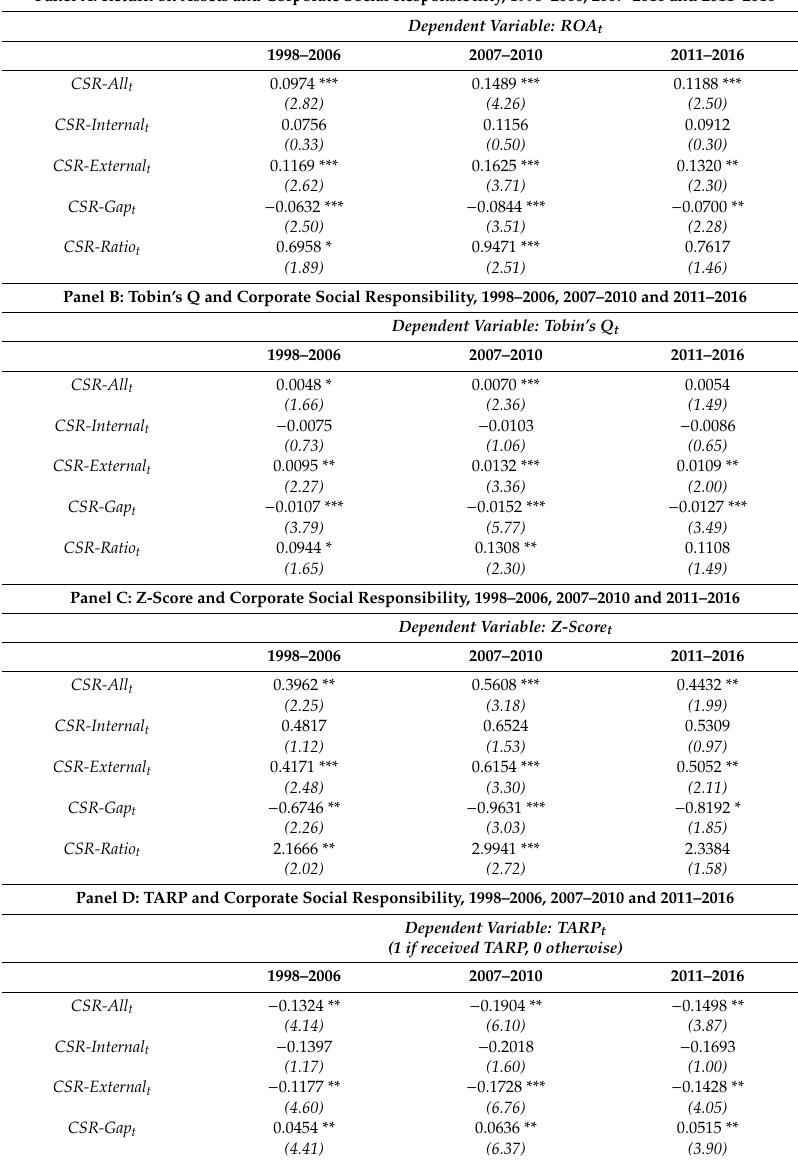
Table 7. Corporate Social Responsibility by Time Period. This table presents results from re-estimating each of the previous analyses during three sub-periods: 1998–2006, 2007–2010 and 2011–2016. In Panel A, the Equation (1) CSR-performance relationship is estimated for each of these sub-periods with Return on Assets, or ROA , as the measure of performance. In Panel B, the Equation (1) CSR-performance relationship is estimated for each of these sub-periods with Tobin’s Q as the measure of performance. In Panel C, the Equation (2) CSR-risk relationship is estimated for each of these sub-periods with Z-Score as the measure of risk. And, in Panel D, the Equation (2) CSR-risk relationship is estimated for each of these sub-periods with TARP as the measure of risk. All details for Panels A and B are as in Table 3; all details for Panel C are as in Table 5; and, all details for Panel D are as in Table 6. While the full equation is estimated in each case, for conciseness, only the coe ffi cients and p -values for the CSR variables are presented. Statistical significance is indicated with *** for 1%, ** for 5% and * for